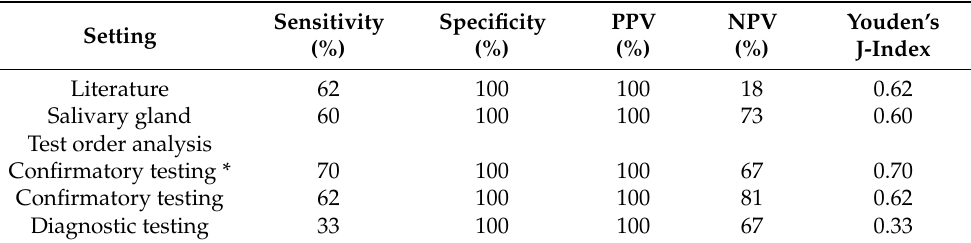
Table 2. Four sets of test performance metrics for MAML2 rearrangement as a biomarker for the diagnosis of MEC demonstrated differing patterns by